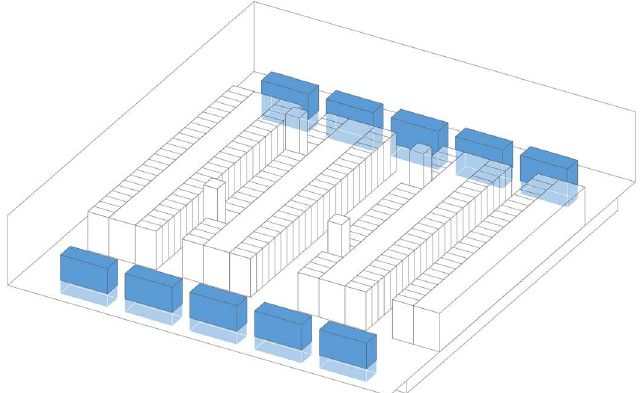
Figure 4. 3D model of data center.